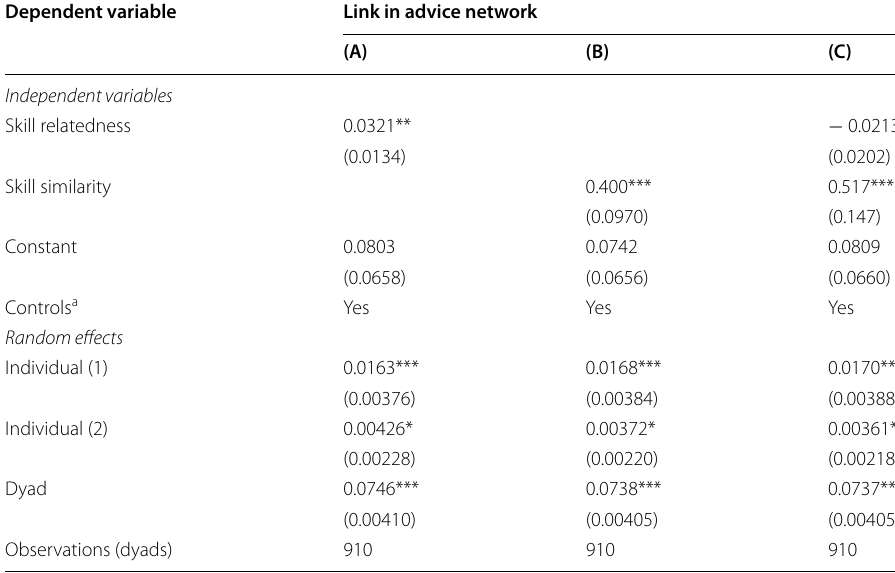
Table 2 The relationship between skill relatedness and skill similarity and links in the advice-seeking